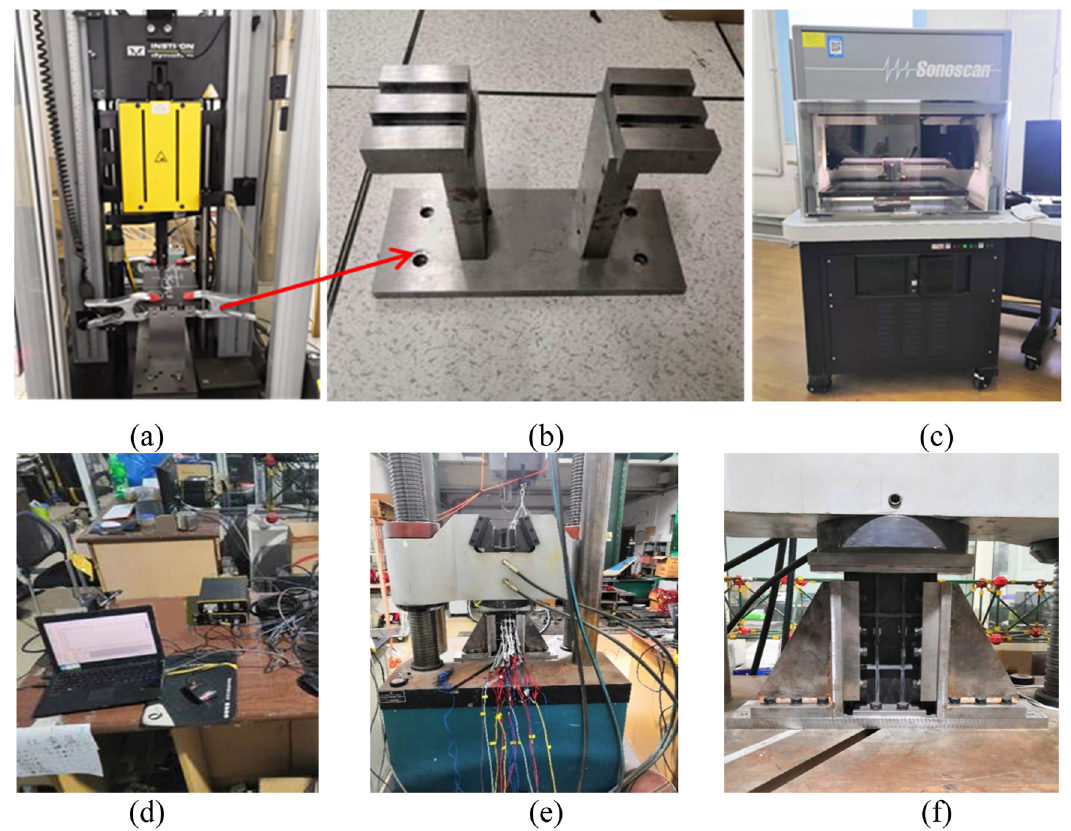
Figure 2: ( a ) Impact testing machine; ( b ) impact fi xture; ( c ) ultrasound C - scan; ( d ) strain detection system; ( e ) compression testing machine; and ( f ) compression fi xture.